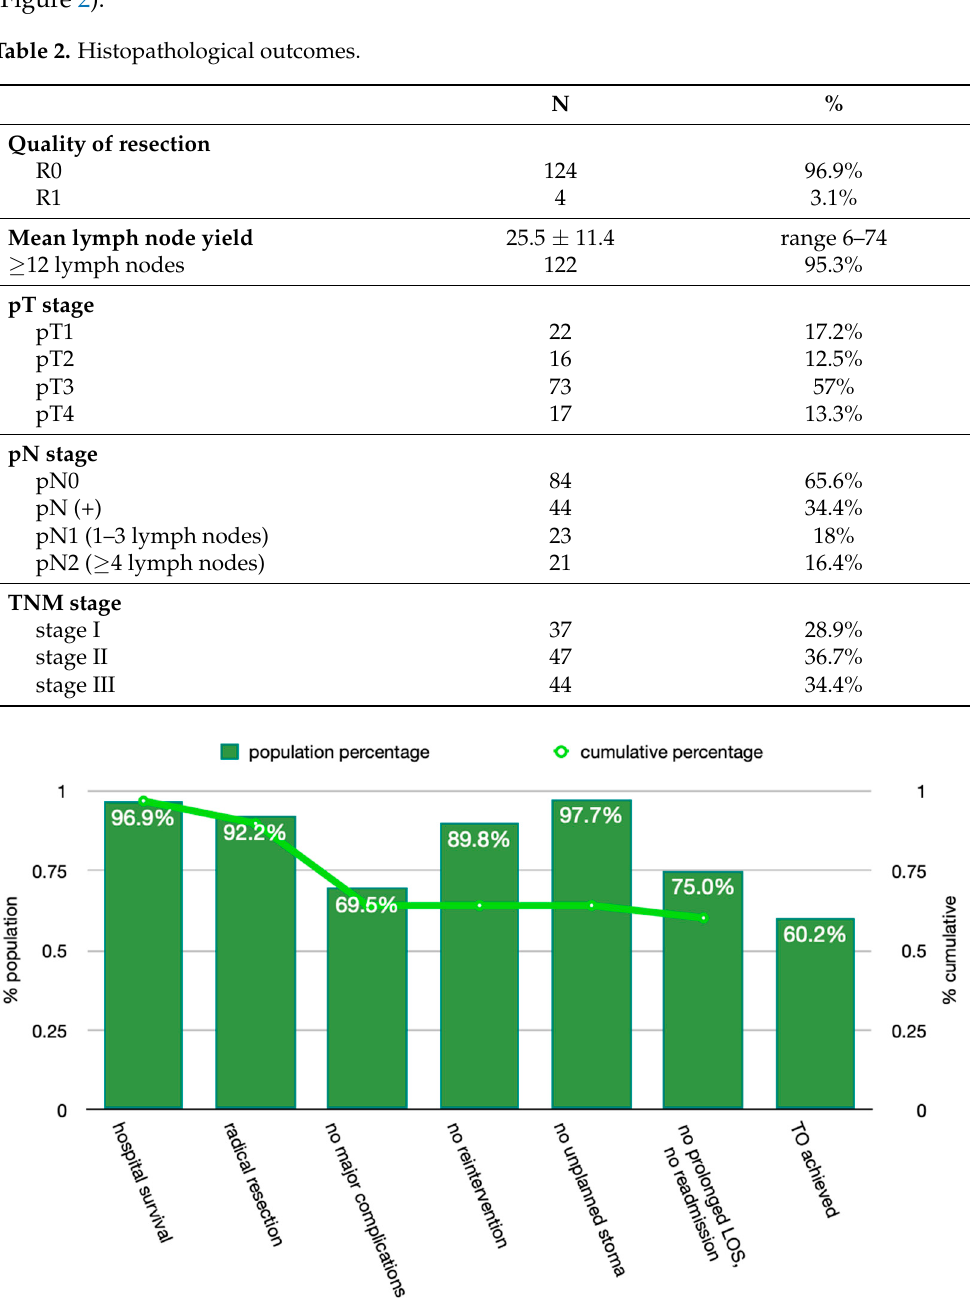
Figure 1. Textbook Outcome parameters (Bars depict the percentage of patients meeting each individual criterion. Line depicts the cumulative percentage of patients meeting each criterion, on condition that all previous criteria are also met).